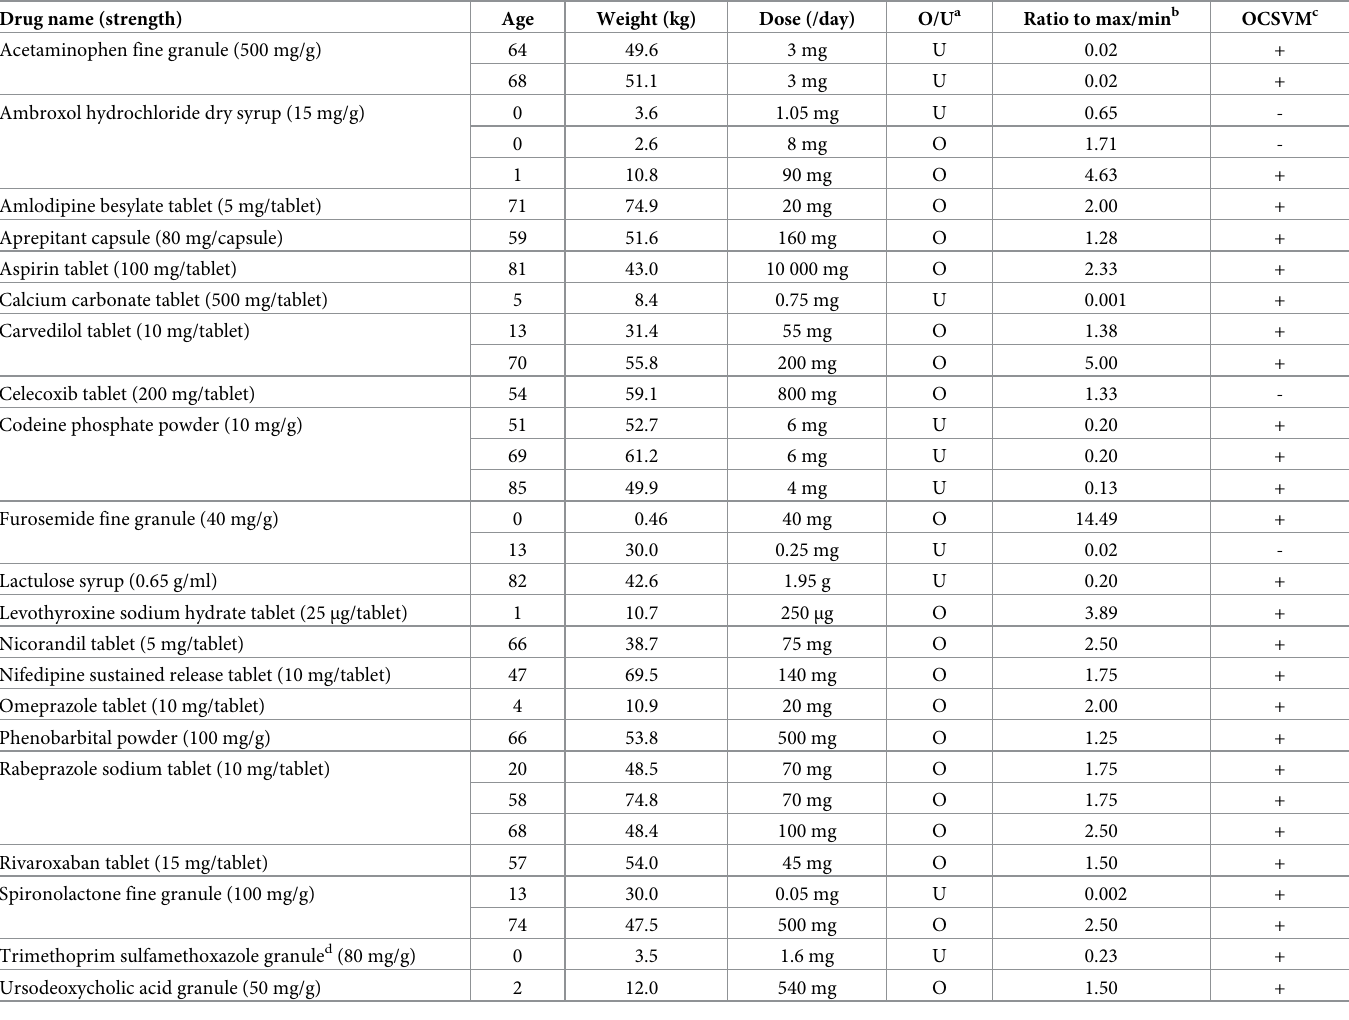
Table 2. Details of clinical overdose and underdose prescriptions and detection results by OCSVM